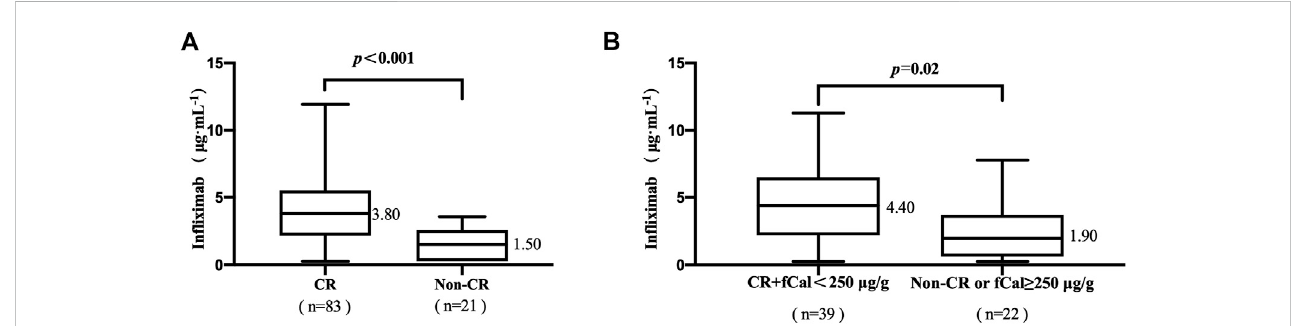
FIGURE 1 (A) Association between trough levels of in fl iximab (TLI) and clinical remission (CR). (B) The association of TLI with CR and faecal calprotectin (fCal) normalization. Clinical remission (CR) was de fi ned by a Crohn ’ s disease activity index (CDAI) < 150 points. Normalization of faecal calprotectin (fCal)